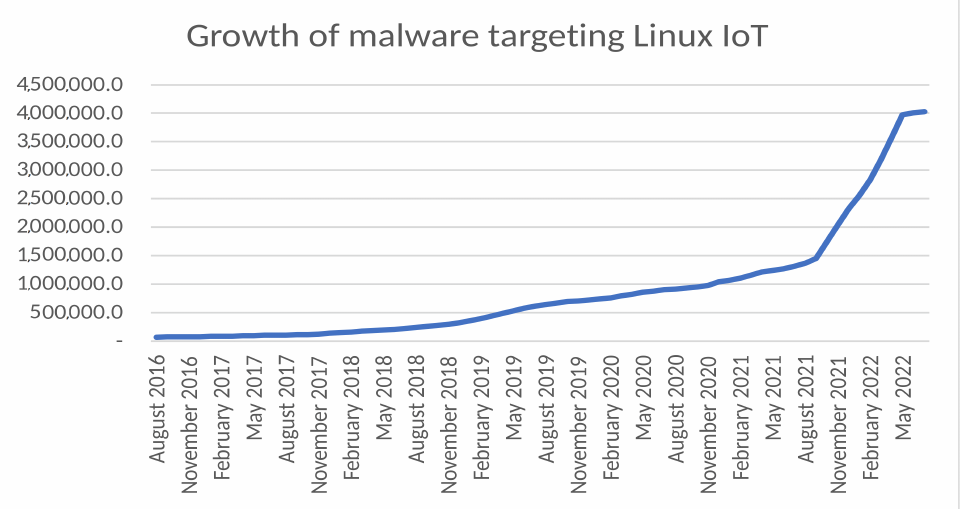
Figure 1. Growth of malware targeting IoT